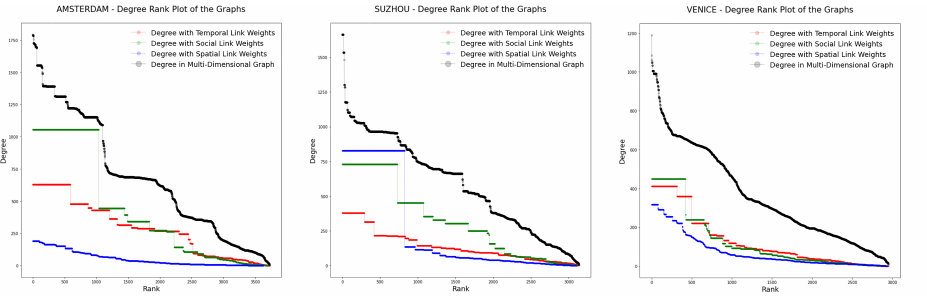
Figure 6. The rank-size plots of the degree distributions in the three cases of Amsterdam, Suzhou, and Venice, with regard to the temporal links, social links, spatial links, as well as the entire